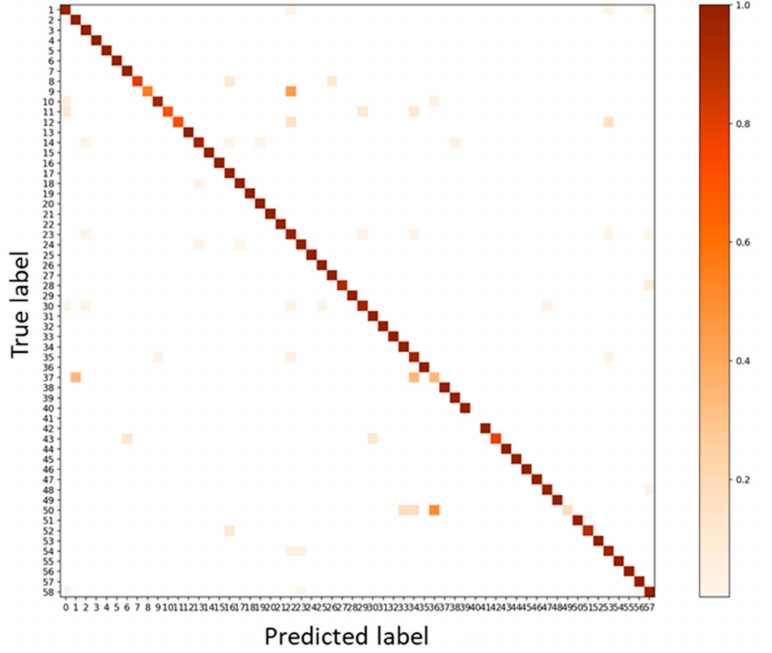
Figure 6. Confusion matrix of random separation dataset: same time or same trees. The vertical axis is the ground truth and the horizontal axis the model prediction. The number in each cell indicates the number of classified images; each cell is colored according to the percentage of the number of images in each class. The model showed 0.98 Kappa